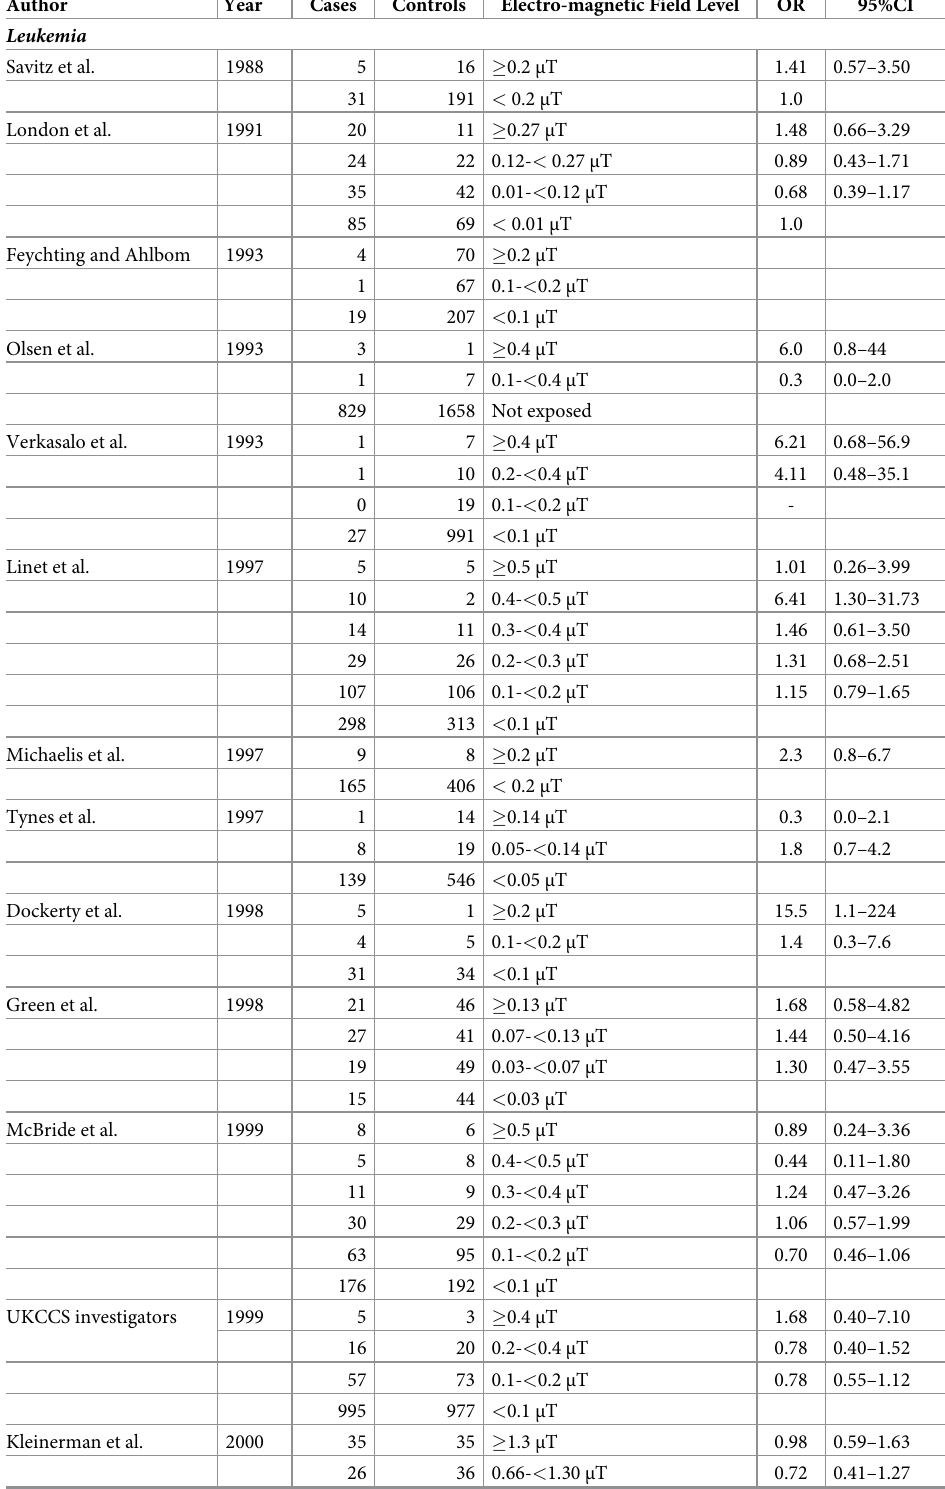
Table 2. Absolute numbers of childhood cancer cases and controls by study and exposure